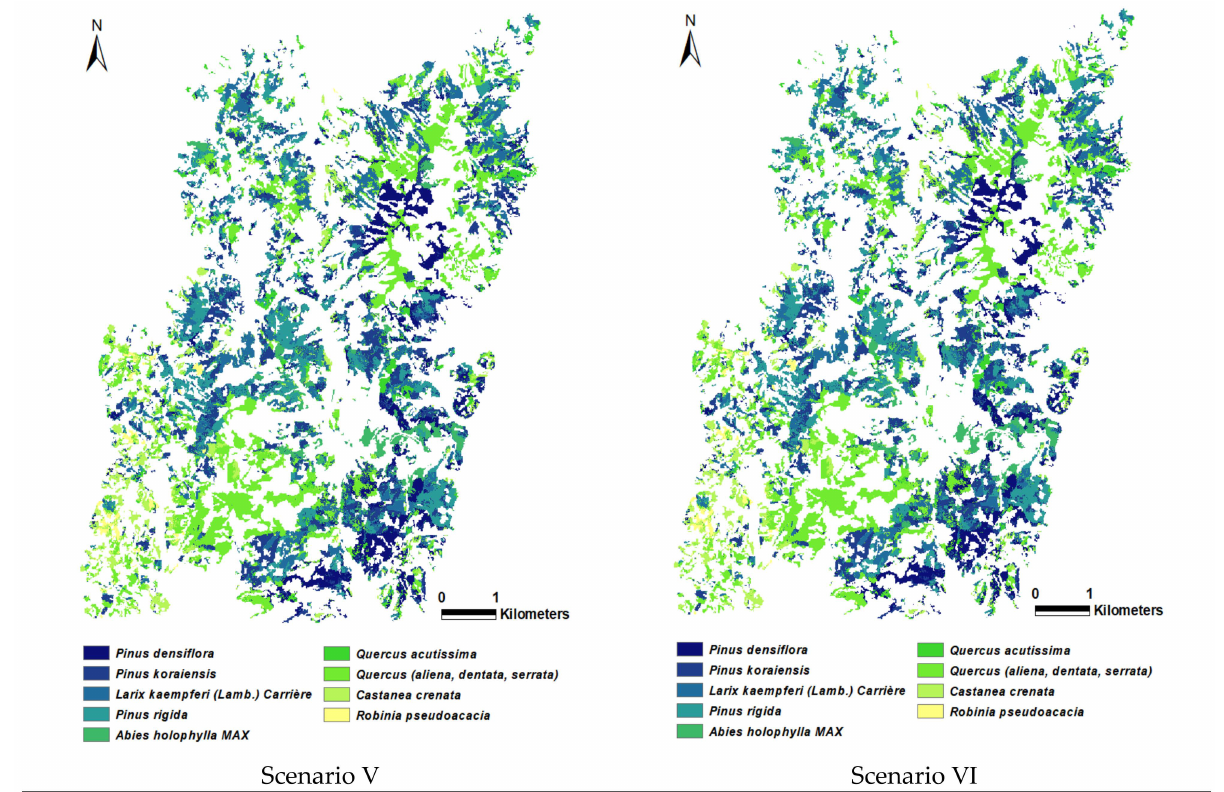
Figure 7. Map of tree species by scenarios using Random